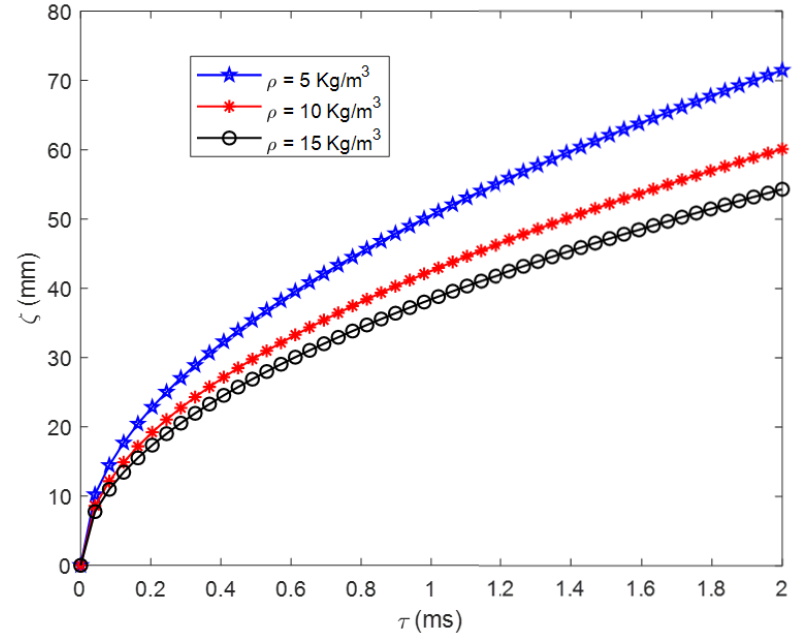
Figure 7. Effect of